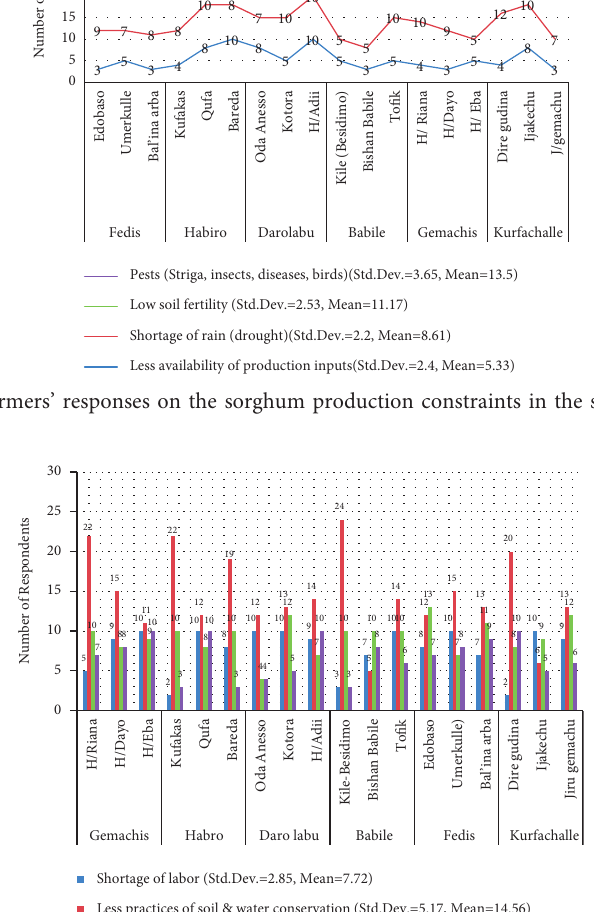
Shortage of labor (Std.Dev.=2.85, Mean=7.72) Less practices of soil & water conservation (Std.Dev.=5.17, Mean=14.56) Less practices of crop rotation (Std.Dev.=2.14, Mean=9.33)